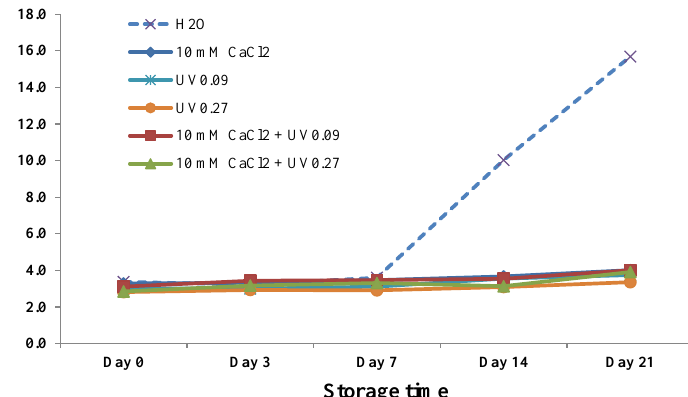
Figure 3. Effect of preharvest treatments on tissue electrolyte leakage of broccoli microgreens after 0, 3, 7, 14, and 21 d of storage at 4 °C. UV0.09: 0.09 Wh/m 2 UVB; UV0.27: 0.27Wh/m 2 UVB. Data presented are the means of three replicates.